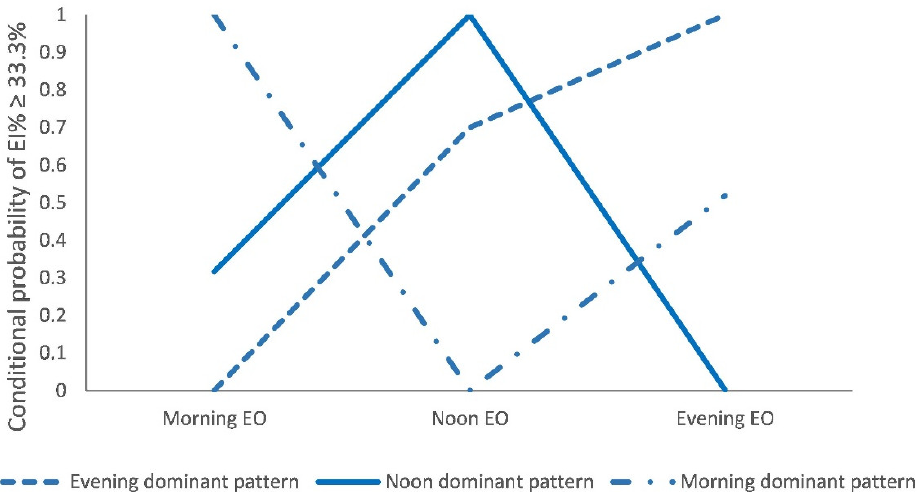
Figure 2. Conditional probability of proportion of total energy intake of ≥ 33.3% across eating occasions (EOs) in a day by latent class membership in Chinese adults. EI% ≥ 33.3% indicates energy contributed more than or equal to 33.3% total energy intake.